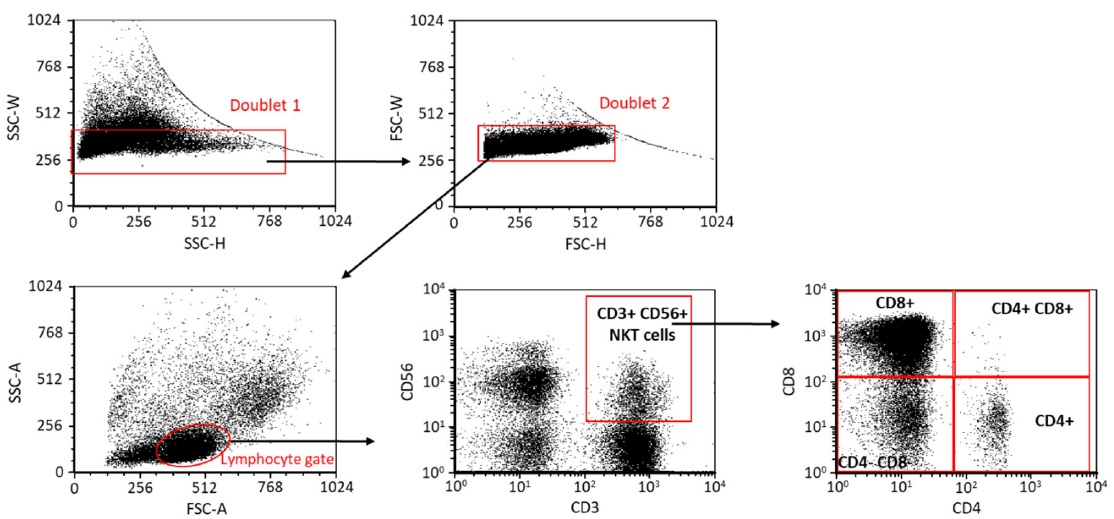
Figure 1. Differentiation of the NKT subpopulations using flow cytometric analyses. Gating strategy for flow cytometry analysis. The selection method to gate the four investigated NKT cell subpopulations.